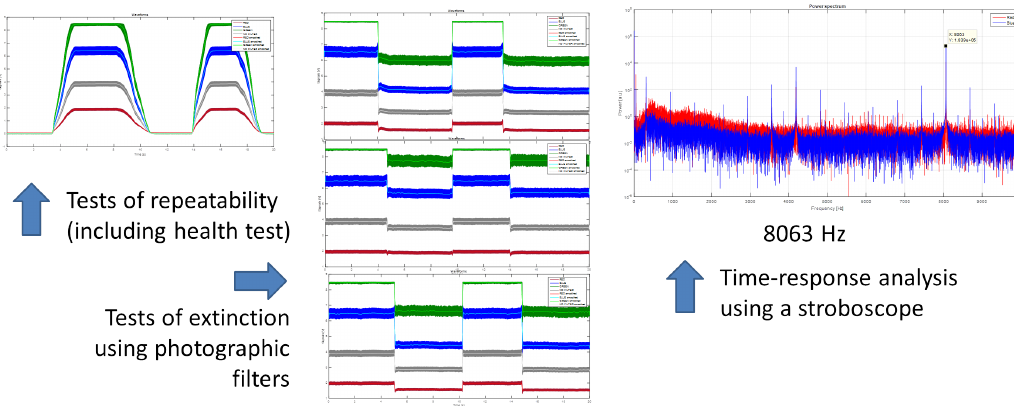
Figure 6. Calibration procedure including tests of repeatability, test of extinction using photographic filters, and time response using a